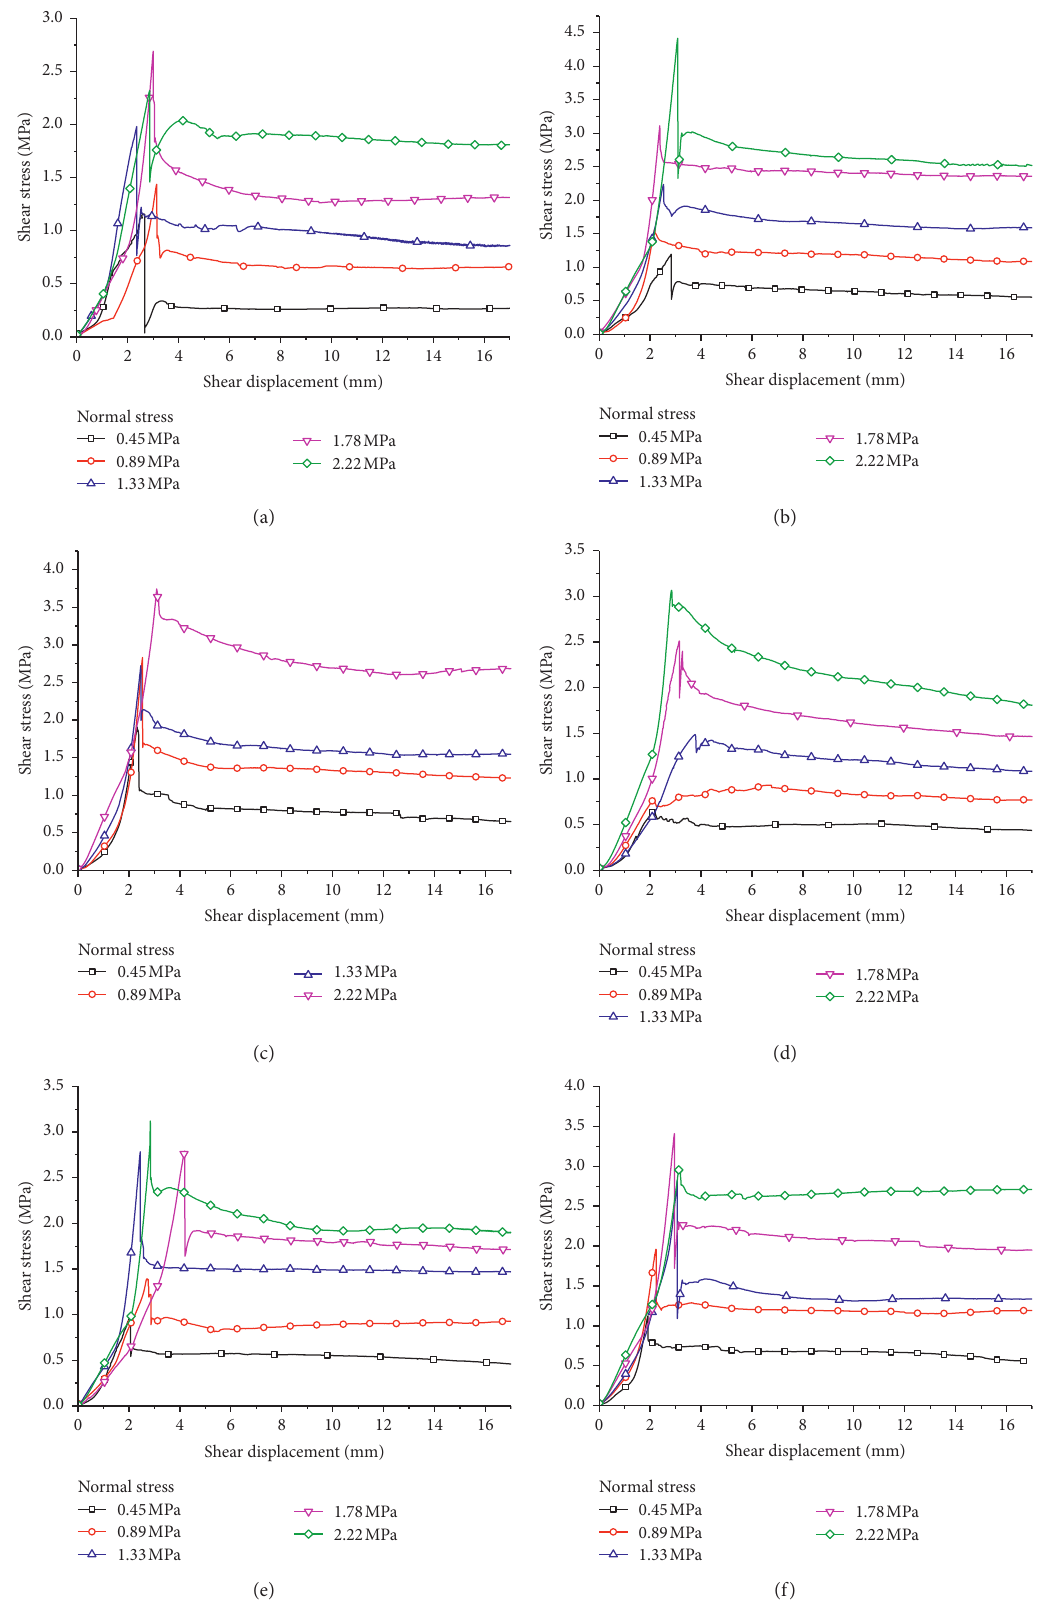
Figure 3: Shear stress-shear displacement curves of bolted joints under different conditions. (a) Joint-1-45 ° . (b) Joint-2-45 ° . (c) Joint-3-45 ° . (d) Joint-1-90 ° . (e) Joint-2-90 ° . (f) Joint-3-90 °